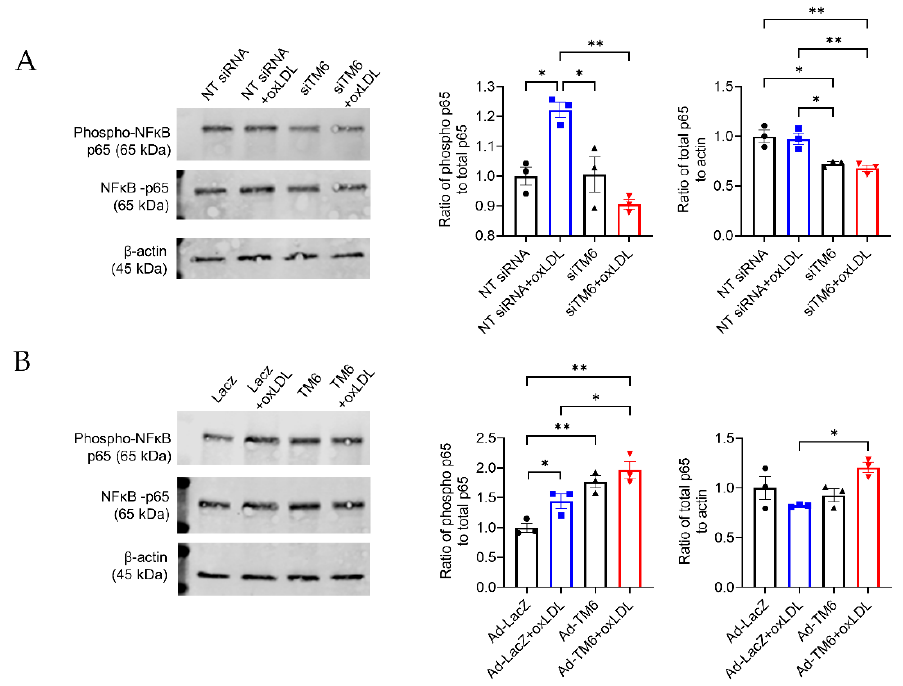
Figure 6. TM6SF2 increases p65 phosphorylation in THP-1-derived macrophages. ( A ) THP-1-derived macrophages were transfected with NT siRNA or TM6SF2 siRNA (20 nM) for 48 h and treated with oxLDL (100 µ g/mL) for 1 h. ( B ) THP-1-derived macrophages were transfected with AdLacZ or AdTM6SF2 (100 MOI) for 48 h and treated with oxLDL (100 µ g/mL) for 1 h. phospho-p65 and total p65 levels were determined by Western Blotting. Representative results and quantifications were shown. n = 3 for each group. All data are presented as mean ± SEM, statistics by Ordinary one-way ANOVA. * p < 0.05, ** p < 0.01 as indicated.